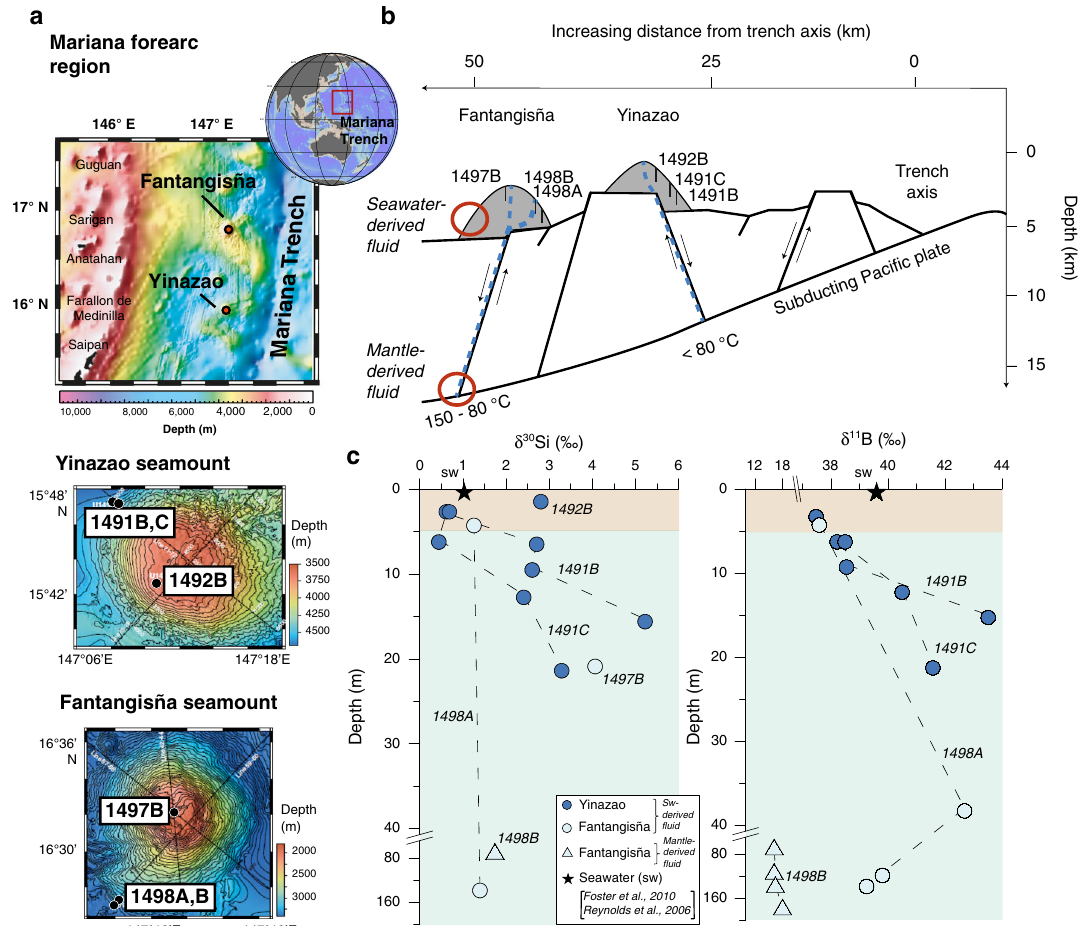
Fig. 1 Sampling location and isotope results. a Sampling area of the two seamounts (Yinazao and Fantangisña) investigated during IODP Expedition 366 and close up of the sample locations for both seamounts and ( b ) sketch of the Mariana forearc region with indicated sampling locations (modi fi ed after Fryer et al. 28 ). Blue dotted lines indicate fl uid fl ow along faults. Note mantle-derived fl uid fl ow for site 1498B (see sections “ Origin of pore fl uids ” and “ Drivers of deep mantle-derived δ 30 Si and δ 11 B values ” ). c Isotope compositions versus depths (m) are displayed for δ 30 Si and δ 11 B. Error bars (2 SD of individual measurements) are within symbol size. Brown area denotes depth of uppermost pelagic clays ( ≤ 5 m depth) and green area shows mineralogy dominated by serpentinites and ma fi c